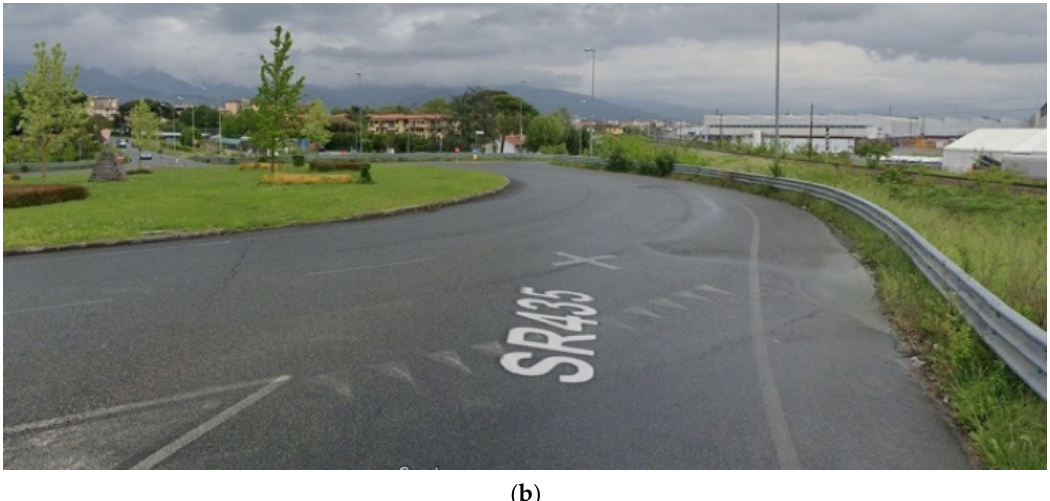
Figure A9 . 1st Case study, Road SR435: ( a ) in 2012; ( b ) in 2019. Figure A9. 1st Case study, Road SR435: ( a ) in 2012; ( b ) in 2019.